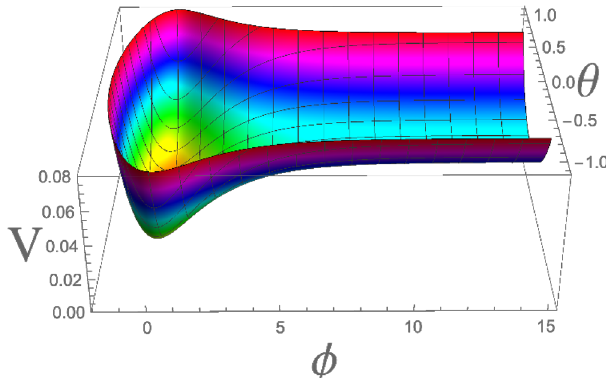
Figure 13 . The potential V infl of the E-model with one flat direction for m = 0 . 2 , W 0 = 0 . 1 , in Planck mass units. Inflation begins at large φ , and ends when the field reaches the vicinity of the minimum at φ = 0